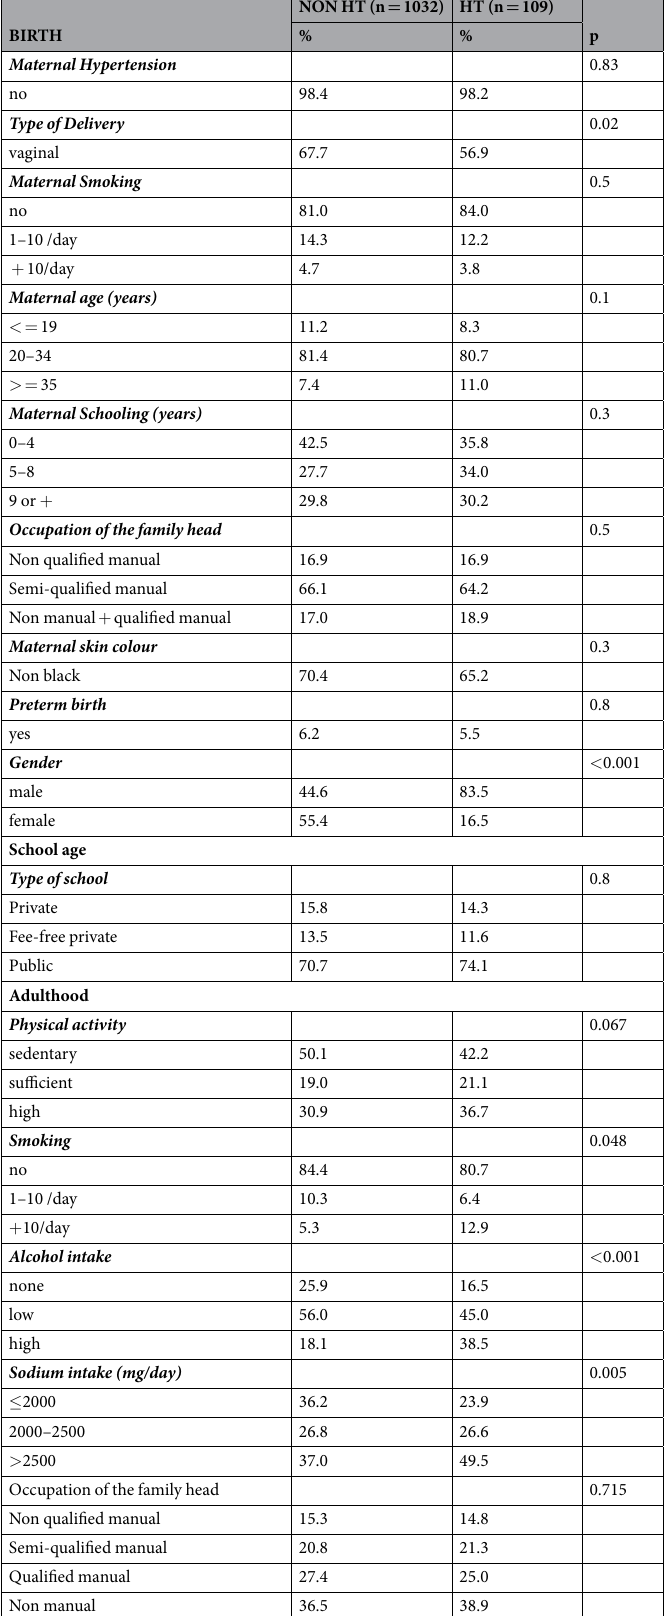
Table 3. Selected characteristics of a population–based birth cohort born in 1978–79 in Ribeirao Preto, Brazil, by hypertension status in adulthood. HT = hypertension; statistic test: chi-square or chi-square for trend